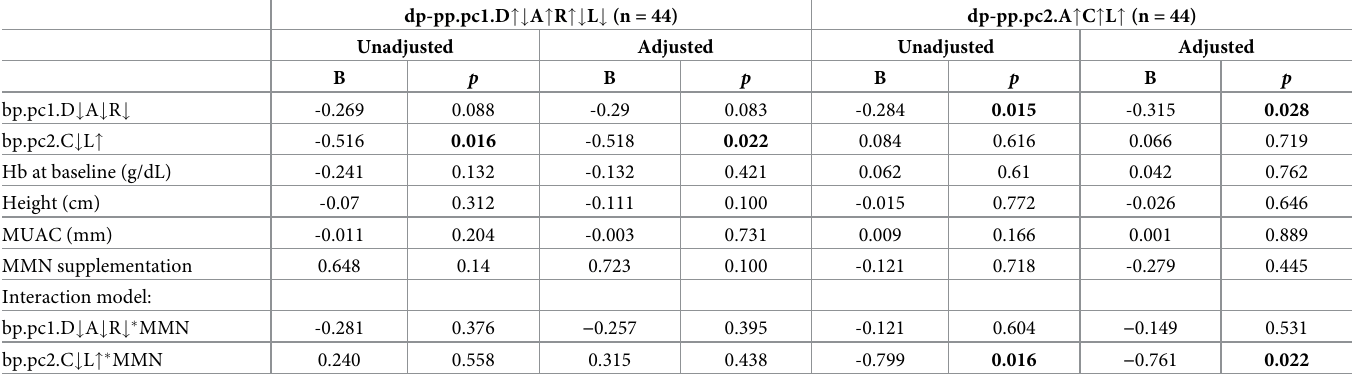
Table 5. Associations of maternal baseline pregnancy components, maternal nutrition, and multiple micronutrient supplementation with and post-supplementa- tion